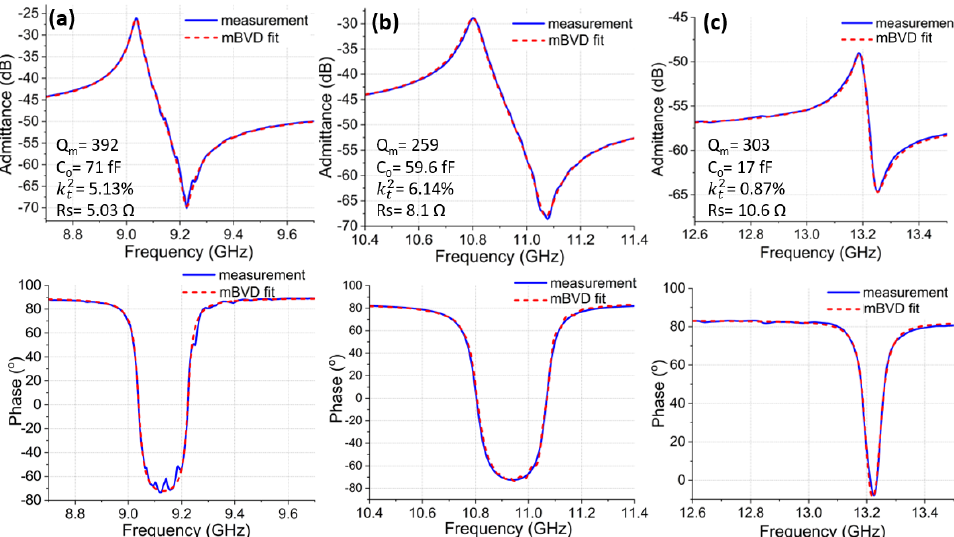
Figure 8. Admittance ( top ) and phase ( bottom ) response of Al 72 Sc 28 N CLMRs fitted to the mBVD model: ( a ) CLMR operating at 9.04 GHz with W e = 445 nm. ( b ) CLMR operating at 10.8 GHz W e = 300 nm. ( b ) CLMR operating at 13.19 GHz W e = 150